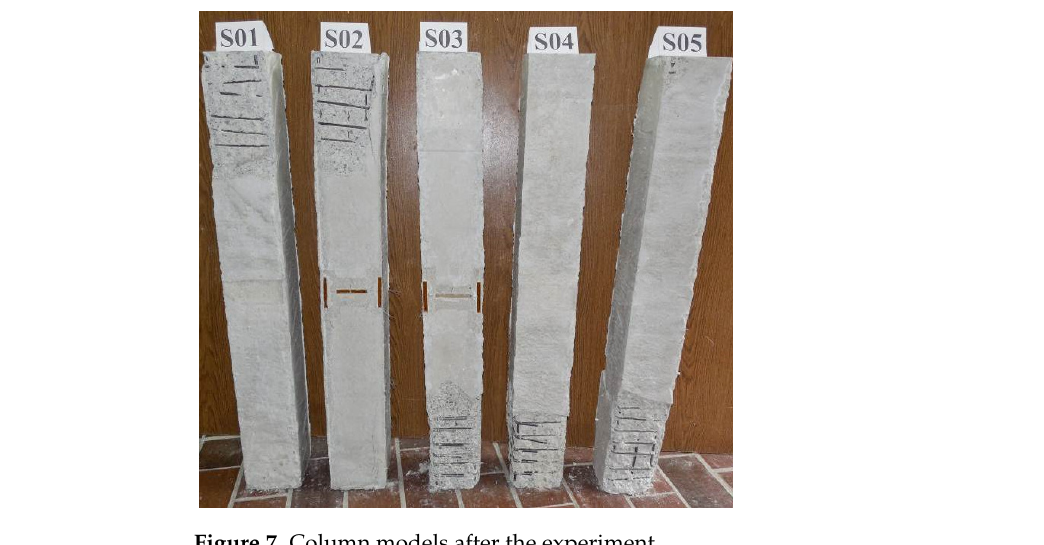
Figure 6. Failure modes of plain RC columns. The bottom part of specimen S03 ( a ), and the top part of specimen S02 ( b ).